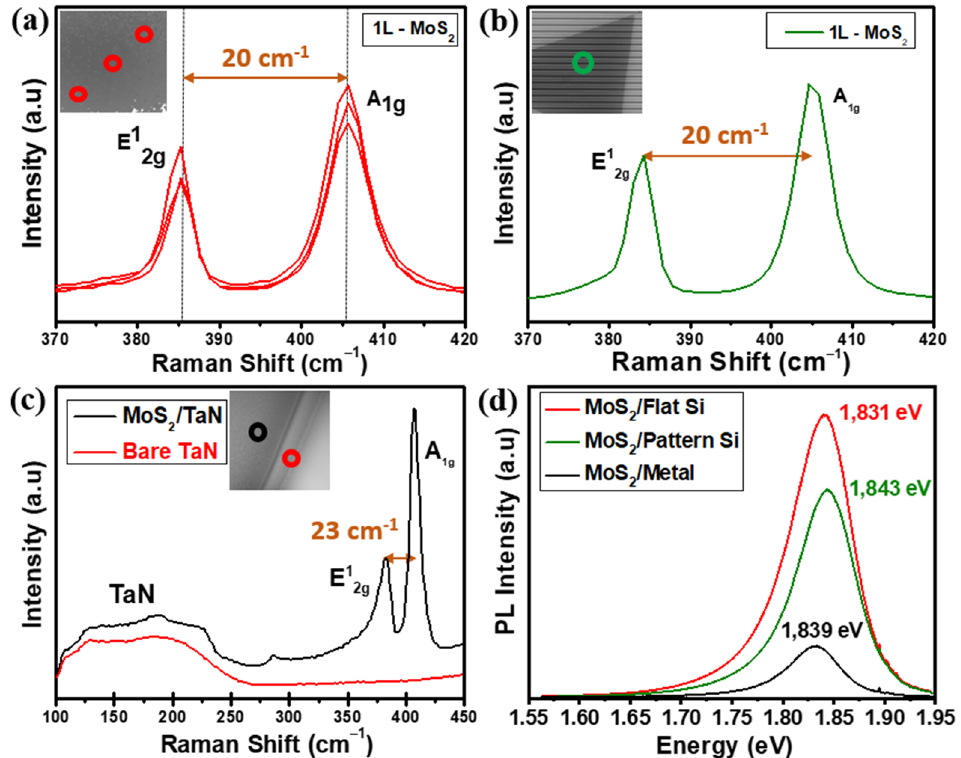
Figure 3. ( a ) Raman spectra obtained at different positions on the as-grown horizontal monolayer MoS 2 nanosheets on flat SiO 2 /Si; the inset shows the SEM image with the positions of the Raman measures with red open circles ( b ) Raman spectrum taken on monolayer MoS 2 on pattern substrate; the inset shows the SEM image with the position of the Raman measure with green open circle. ( c ) Raman spectra of bare TaN substrate (red) and after three layers MoS 2 grown on TaN (black); the inset shows the SEM image with the positions of the Raman measures on TaN substrate with red and MoS 2 grown on TaN black open circles ( d ) PL spectra of a MoS 2 on flat Si (red), pattern SiO 2 /Si (green) and TaN (black)